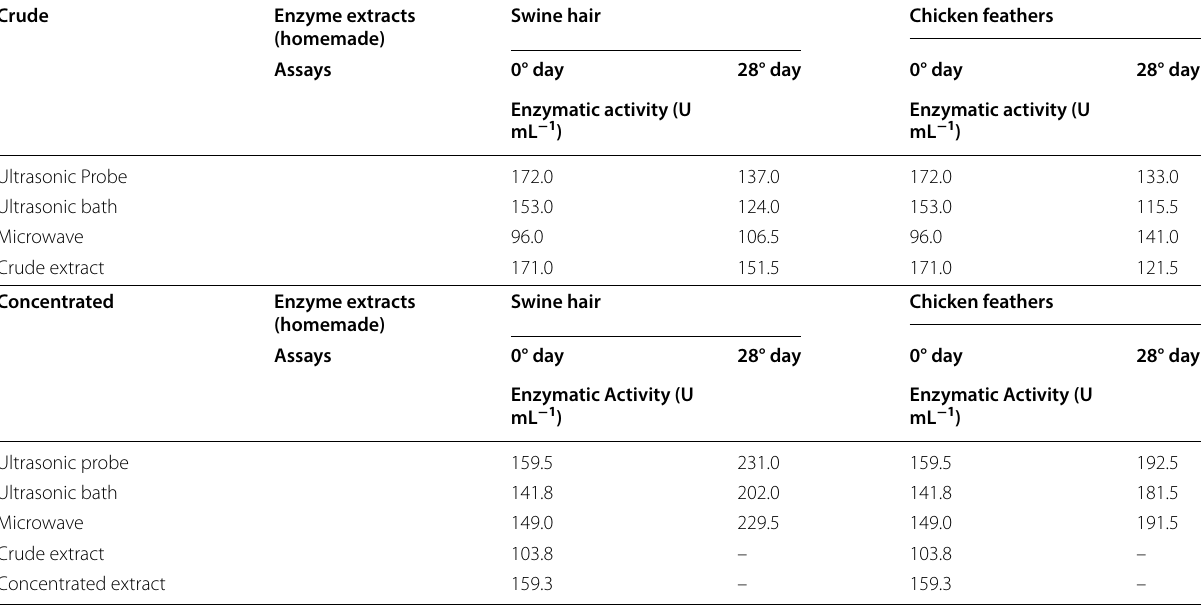
Table 6 Measure of keratinolytic activity at initial time and after 28 days for homemade enzymatic extract crude and concentrated and enzymatic extracts after exposure to ultrasonic reaction systems and microwave irradiation containing swine hair and chicken feathers